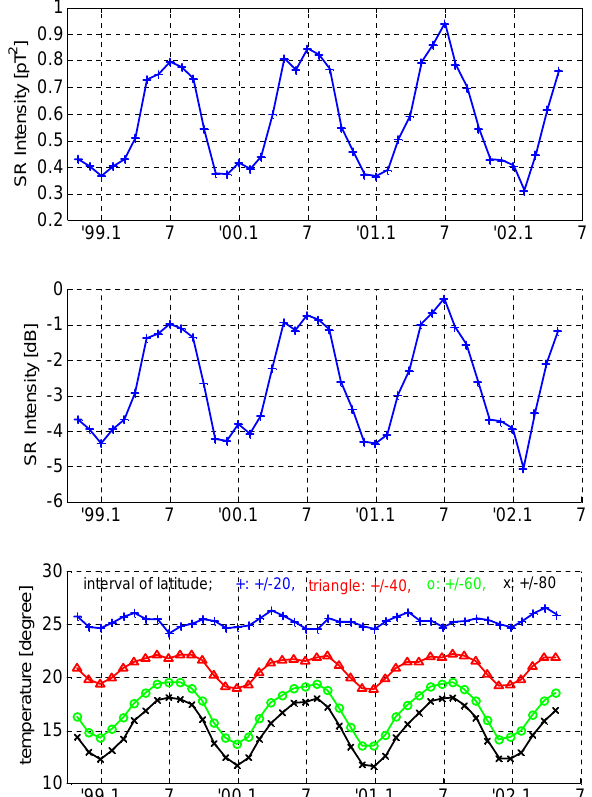
Fig. 2. Monthly averaged diurnal variation of the cumulative en- ergy of Schumann resonance. The color code is used to indicate the absolute intensity (in pT 2 ) (and also in dB).